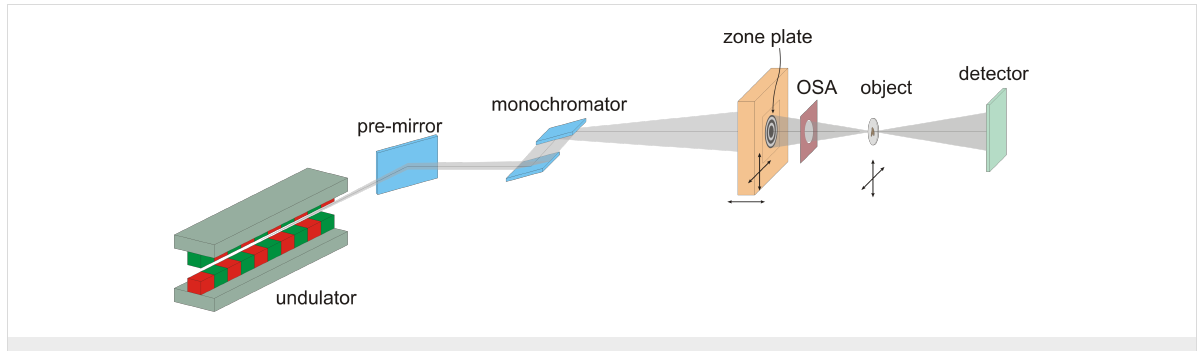
Figure 3: Schematic setup of a scanning transmission X-ray microscope (STXM).